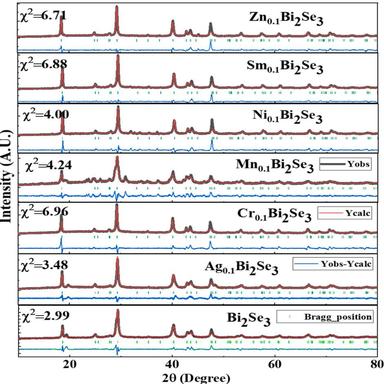
The Rietveld refinement of powder XRD data of all the intercalated TMs and pure Bi2Se3.